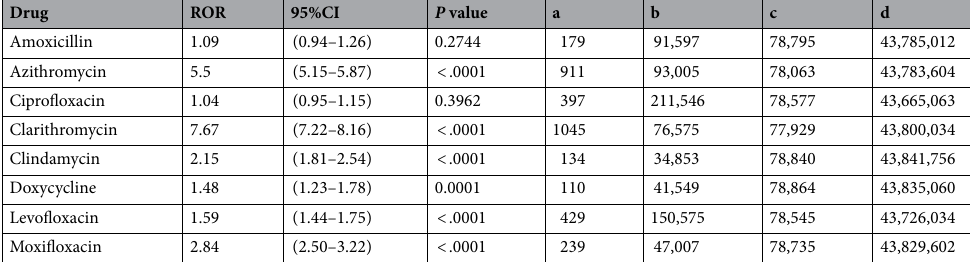
Table 1. ROR of antibiotics that cause taste and smell disorders. a Number of reports of taste and smell disorders due to antibiotics, b: Number of reports of taste and smell disorders other than antibiotics, c: Number of reports of other AEs due to antibiotics, d: Number of reports of other AEs other than antibiotics. The results of the analysis of clindamycin and moxifloxacin indicate those of clindamycin hydrochloride and moxifloxacin hydrochloride, respectively. (see Supplementary Table S1-S2.)